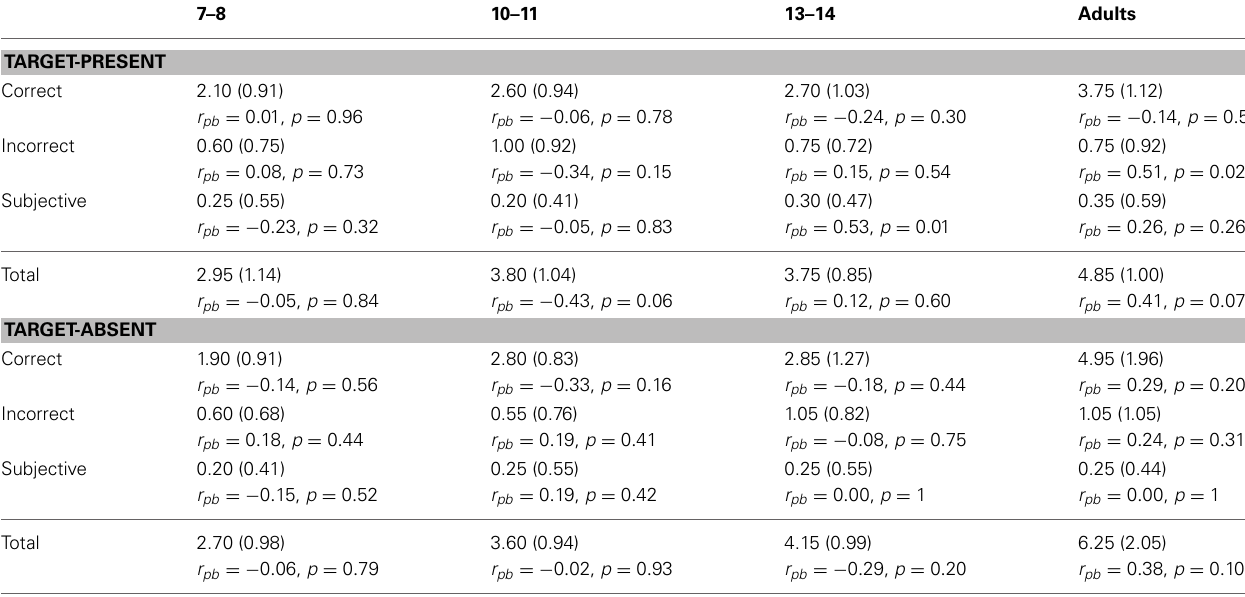
Table 3 | Mean number of reported descriptors in Experiment 2 as a function of Age and Target presence (standard deviations are presented in